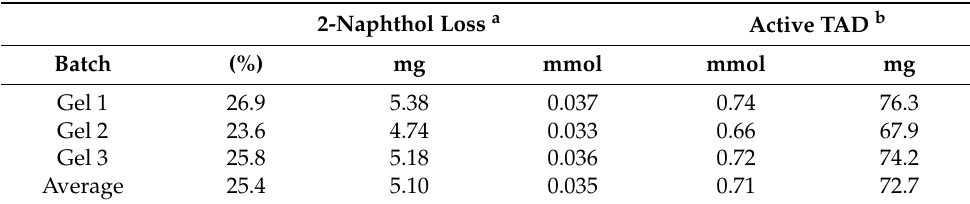
Table 1. Triazolinedione contents of gels via 2-naphthol loss experiment.